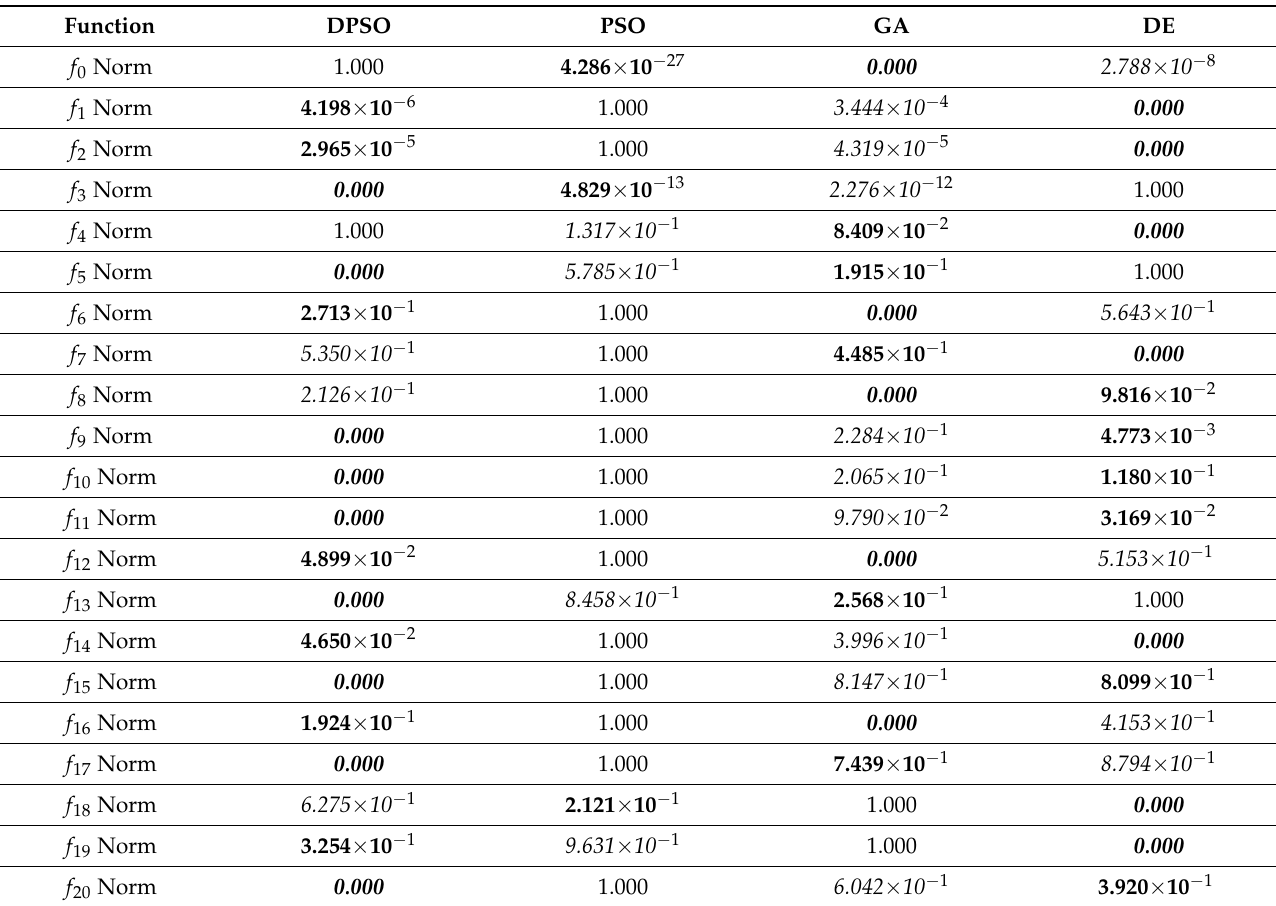
Table 2. Normalized fitness w.r.t. each function problem with 7 dimensions and the resulting ranking: rank 1 (best) , rank 2 , rank 3 , and rank